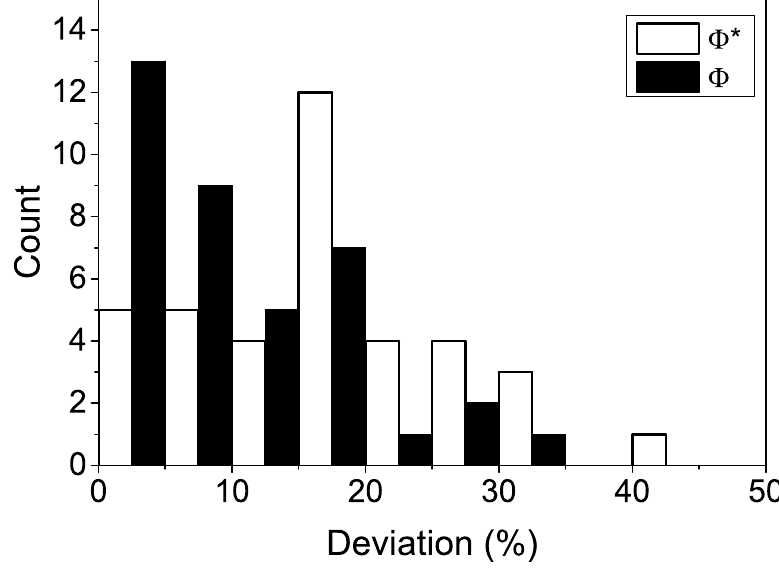
Figure 4. Histogram of the deviation of the estimated forming times from the experimental